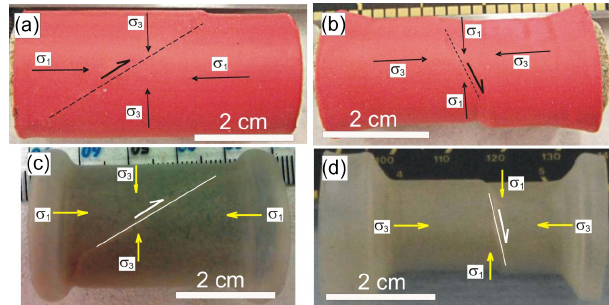
Figure 6. Photographs of fresh faults in shortened cylinders of (a) Darley Dale sandstone (DDa18 at 30MPa confining pressure), (c) Pennant sandstone Pen23 at 40MPa and extended cylinders (b) Darley Dale sandstone DDa19 at 250MPa and (d) Pennant sand- stone Pen38 at 300MPa confining pressure. Samples are still in their heat-shrink rubber jackets. Fault planes and shear senses are indicated. In shortened samples faults make larger angles with the maximum stress than in extended